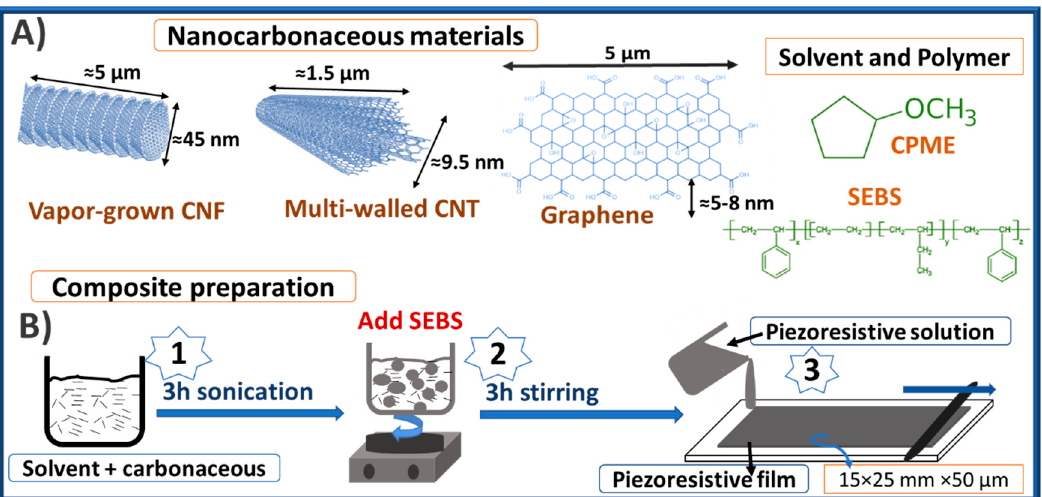
Figure 1. Schematic representation of ( A ) the used nanocarbonaceous materials, solvent, and polymer; and ( B ) the composite preparation route. CNF: carbon nanofibers; CNT: carbon nanotubes; CPME: cyclopentyl methyl ether; SEBS: styrene-b-(ethylene-co-butylene)-b-styrene.